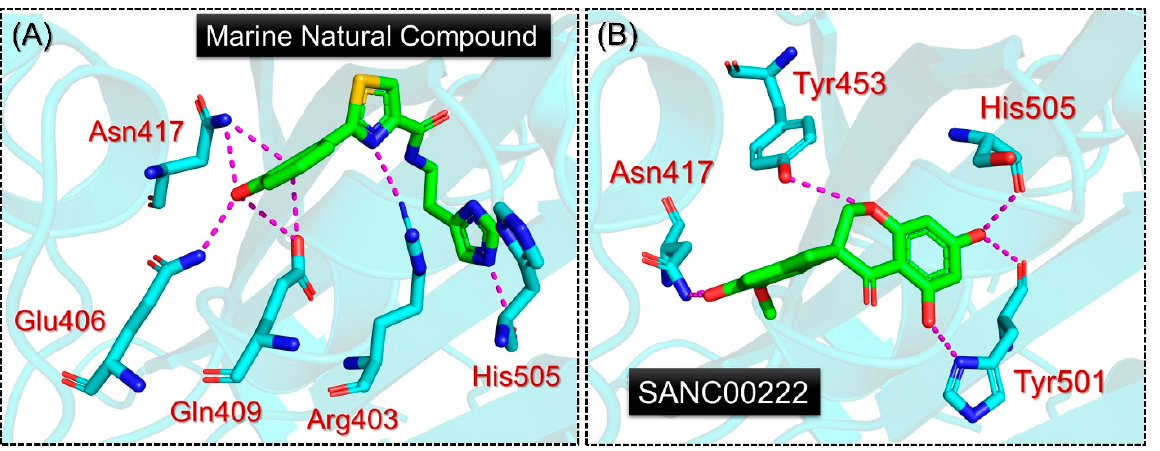
Figure 3. Interaction patterns of MNC and SANC00222 with RBD. ( A ) shows the binding mode of MNC, while ( B ) shows the binding pattern of